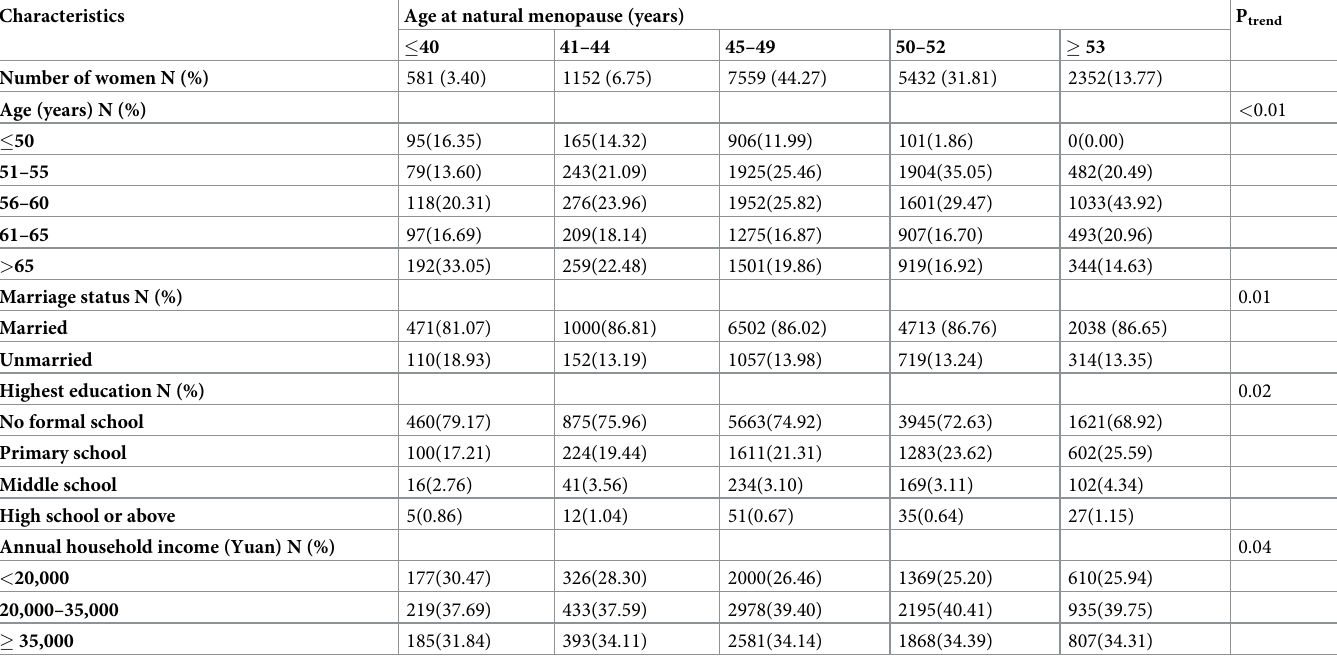
Table 1. Socio-demographic characteristics of women according to age at natural